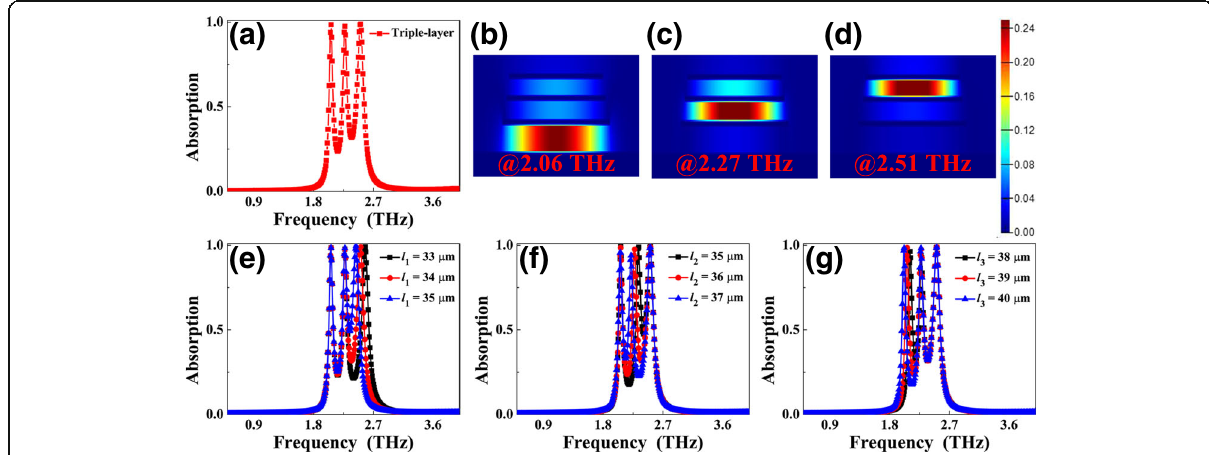
Fig. 4 Absorption curve of triple-band MPA under plane wave irradiation is given in a ; b , c , and d show the | H y| field distributions of the first, the second, and the third modes of the triple-band MPA, respectively. Absorption curves of the triple-band MPA under different lengths of l 1 , l 2 , and